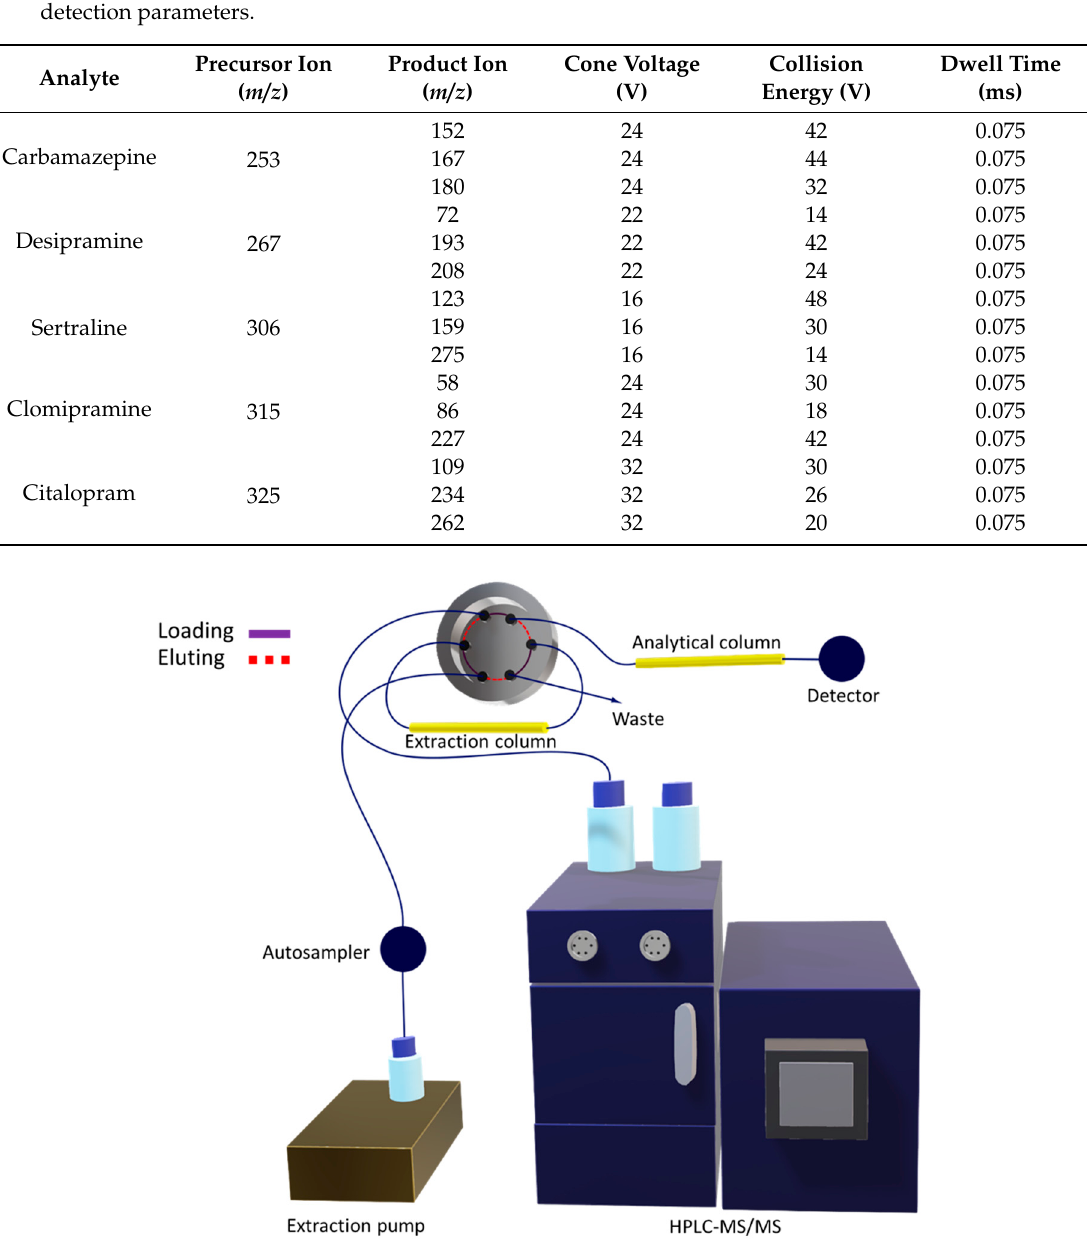
Table 3. Analytes’ multiple reaction monitoring (MRM) precursor and product ions and its main detection parameters.